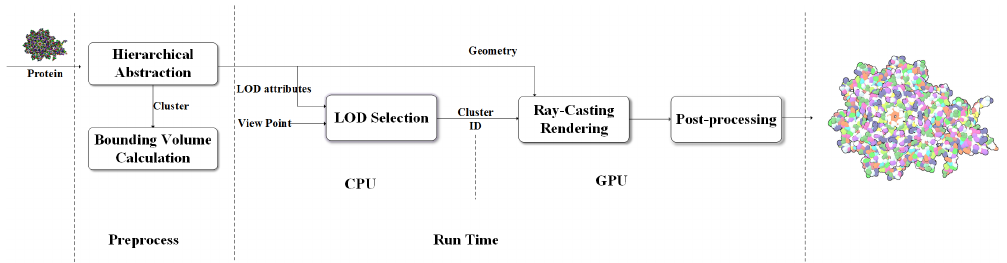
Figure 6. An illustration of the level of detail (LOD) rendering pipeline.Real-time computing mainly occurs in central processing unit (CPU) and graphics processing unit (GPU). At first, we get the cluster tree of molecule and compute the ellipsoids bounding box for each node of tree. The formation of the cluster display list is determined by Equation (2). Clusters are represented as spheres or ellipsoids that are rendered through glyph-based ray-casting algorithm with diffuse shading. In the end, we compute contours and screen space ambient